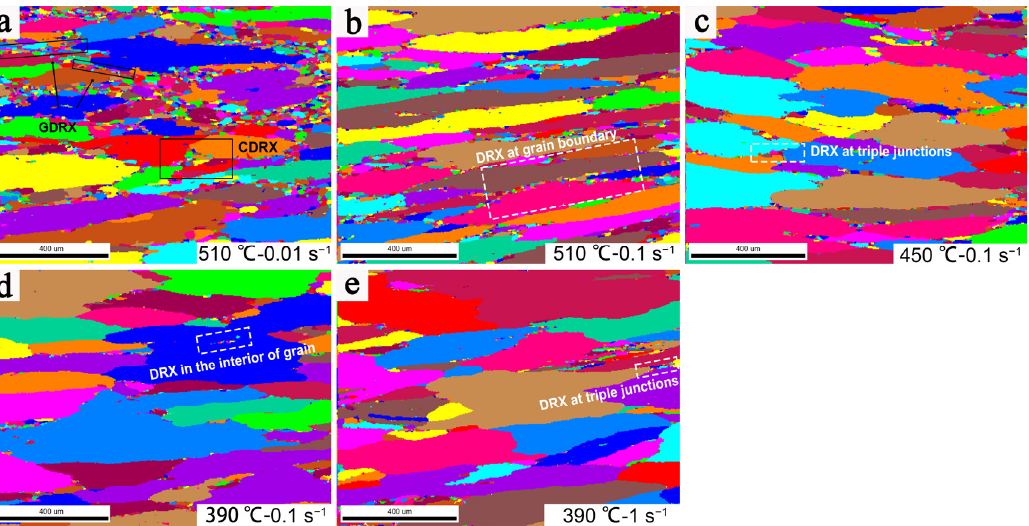
Figure 10. Unique grain color maps of the 2198 alloy hot-deformed at various conditions: ( a ) ln Z = 23.73, ( b ) ln Z = 26.03, ( c ) ln Z = 28.38, ( d ) ln Z = 31.16, and ( e ) ln Z = 33.46.